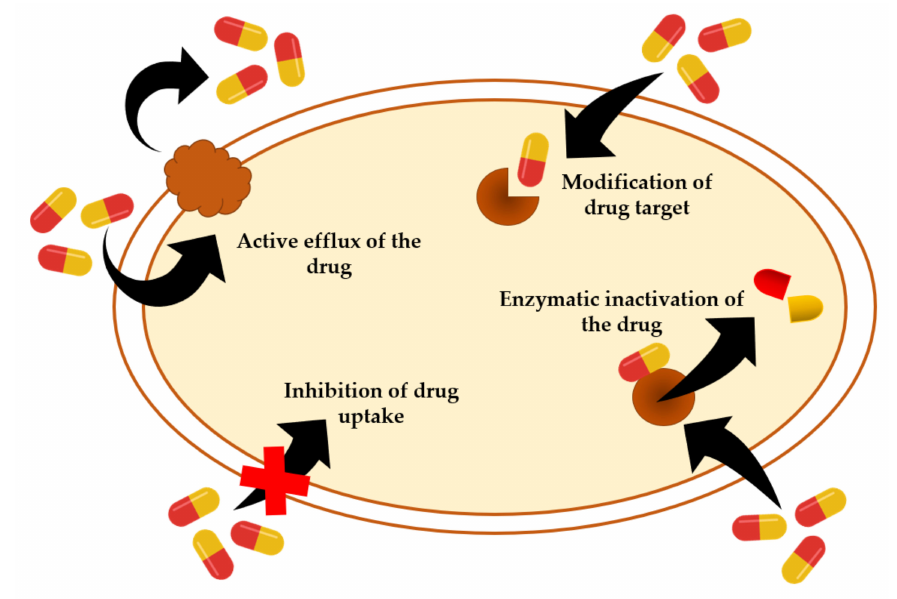
Figure 2. Antimicrobial resistant mechanisms of Staphylococcus aureus